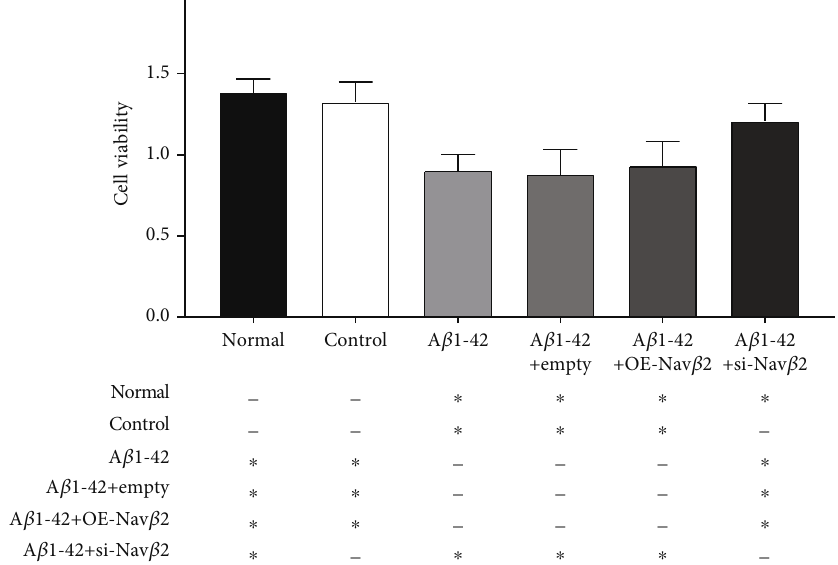
Figure 3: E ff ect of A β 1-42 and Nav β 2 on cell viability in A β 1-42-treated primary neurons. Quantitative image analysis of the cell viability of primary neuron injury model induced by A β 1-42 which transfected with Nav β 2 overexpression (A β 1-42+OE-Nav β 2) or interfering lentiviral vector (A β 1-42+si-Nav β 2). Intragroup sample size n = 5 . ∗ Versus two di ff erent treatment groups, P < 0 : 05 . - Versus two di ff erent treatment groups, P > 0 : 05 . Empty: empty viral vector; OE: overexpression; si: small